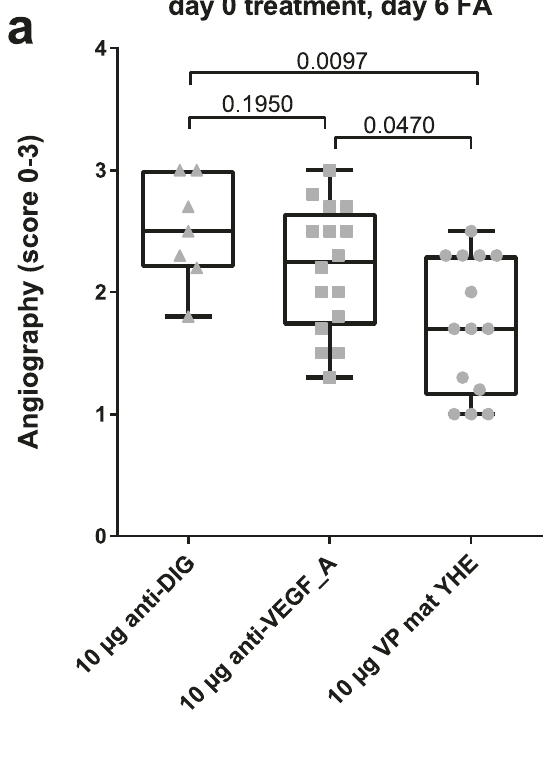
Fig. 6 In vivo ef fi cacy of the VEGF-PDGF DutaFab. The in vivo ef fi cacy of the most potent bispeci fi c DutaFab against VEGFA and PDGF-BB, clone VP mat YHE, was analyzed using a laser-induced choroidal neovascularization (LCNV) model performed in pigmented Brown Norway rats. Each data point shown represents the average fl uorescence angiography (FA) score for the lesions in one eye 6 days post laser treatment. a Result for antibody treatment by a single intravitreal administration on the day of laser